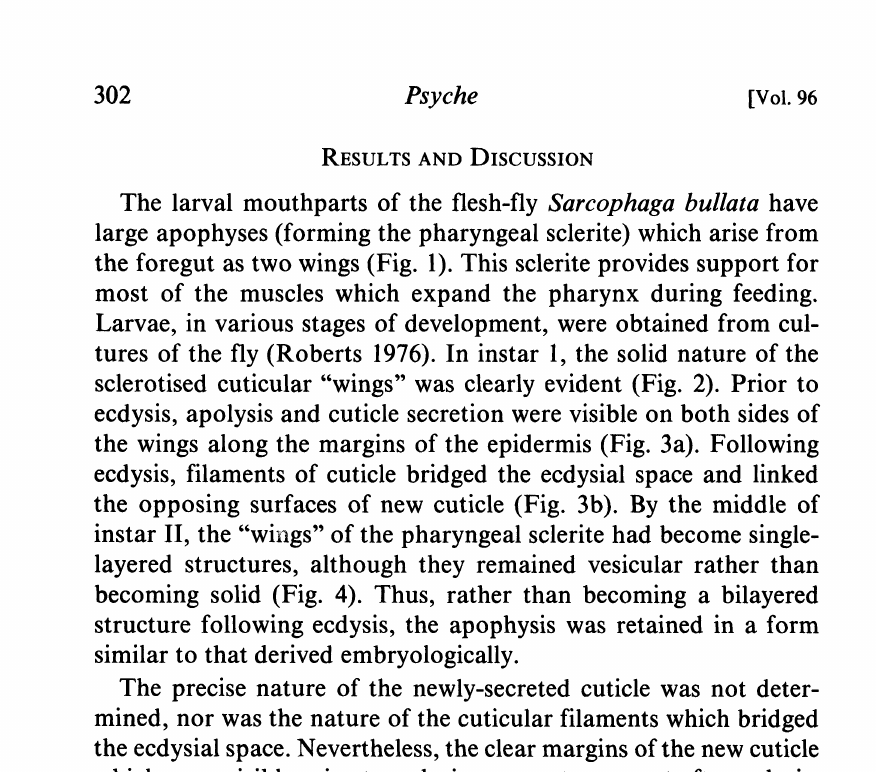
Fig. 1. Mid instar I, lateral view, with the position of the transverse sections indicated. Whole mount, Nomarski Interference Contrast optics. Scale bar: 100m. mh, mouthhooks; p, pharynx; ps, pharyngeal sclerite. Figs. 2-4. Transverse sections of the pharyngeal sclerite. Fig. 2. Mid Instar I. a) Entire sclerite, the position of the section in 2.b is indicated. Scale bar: 10 tm. b) Detail of a "wing" of the pharyngeal sclerite, transmission electron micrograph (TEM). Scale bar: #m. c, cuticle; e, epidermis. Fig. 3. TEM from a similar position as 2.b. a) Late instar just prior to ecdysis, arrows indicate the layers of newly-secreted cuticle. Scale bar: lm. b) early instar II just after ecdysis. Scale bar: #m. cf, cuticular filaments; e,